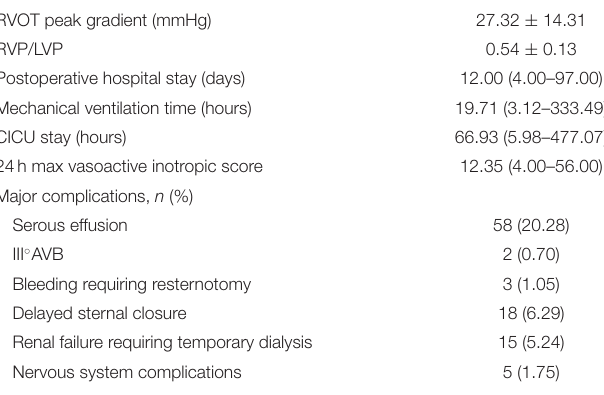
TABLE 2 | Postoperative